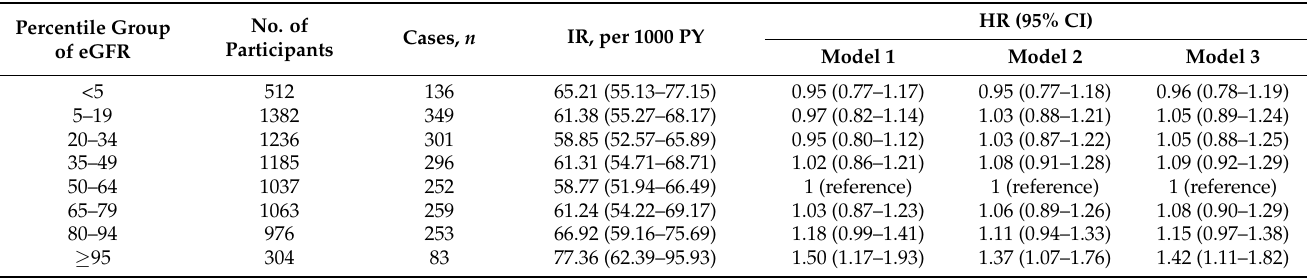
Figure 3. Cumulative incidence of NAFLD by glomerular hyperfiltration status at baseline ( A ) and cumulative incidence of NAFLD by glomerular hyperfiltration status at baseline and at the end of the follow-up ( B ). GHF: glomerular hyperfiltration, NAFLD: nonalcoholic fatty liver disease, Non-GHF: non-glomerular hyperfiltration. Table 3. Risk of advanced liver fibrosis based on NFS according to the eGFR percentile in patients with